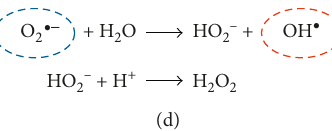
Figure 6: Proposed mechanism for the formation of the superoxide and hydroxyl radicals in MB degradation. (a) Hydrogen peroxide adsorption at an Mn 4+ active site (oxygen vacant) with a posterior electron transfer to the Mn 4+ active site and formation of a superoxide radical and an Mn 3+ inactive site. There is an electron transfer process from an Mn 3+ ion to an adjacent Mn 4+ ion via an oxobridge ( electronic hopping ) to finally regenerate the Mn 4+ active site. (b) A similar step as in (a) but in this case without regeneration of the active side. (c) Oxidation of Mn 3+ with O 2 at the oxygen vacant site to restore the Mn 4+ active site and superoxide radical. (d) Formation of hydroxyl radical (OH • ) and regeneration of hydrogen